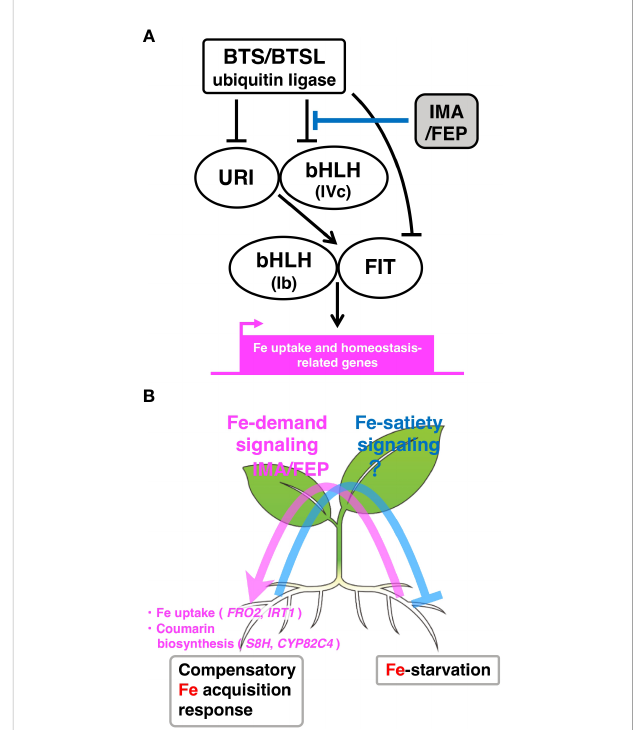
FIGURE 1 Model for IMA/FEP-mediated local Fe-de fi ciency response and systemic Fe signaling under heterogeneous Fe conditions. (A) IMA/FEP-mediated intracellular signaling of the local Fe-de fi ciency response. BTS/BTSL ubiquitin E3 ligases, which are potential Fe sensor proteins, negatively regulate local Fe-de fi ciency responses by degrading of IVc subgroup bHLH TFs, URI and FIT. IMA/FEP peptides compete with IVc subgroup bHLH TFs to interact with BTS/BTSL, which inhibits the degradation of these TFs by BTS/BTSL. The IVc subgroup bHLH TFs form heterodimers with URI to activate the bHLH TF-mediated signaling cascade for the upregulation of Fe uptake and homeostasis-related genes in response to Fe-de fi ciency. (B) Systemic Fe signaling under heterogeneous Fe conditions. Detection of Fe de fi ciency status in one region of the root (right side of the root) is transduced to shoots by an as-yet unknown mechanism, resulting in the upregulation of IMA/FEP peptide expression as a descending signal to roots (pink arrow: Fe-demand signaling). These putative shoot-derived peptides upregulate the expression of Fe uptake and coumarin biosynthesis genes in other root regions (left side of the root) to remediate the local Fe de fi ciency. Conversely, the putative Fe-satiety signal from the Fe-suf fi cient side is conveyed to the Fe-de fi cient side to suppress Fe uptake mechanisms (light blue line: Fe-satiety